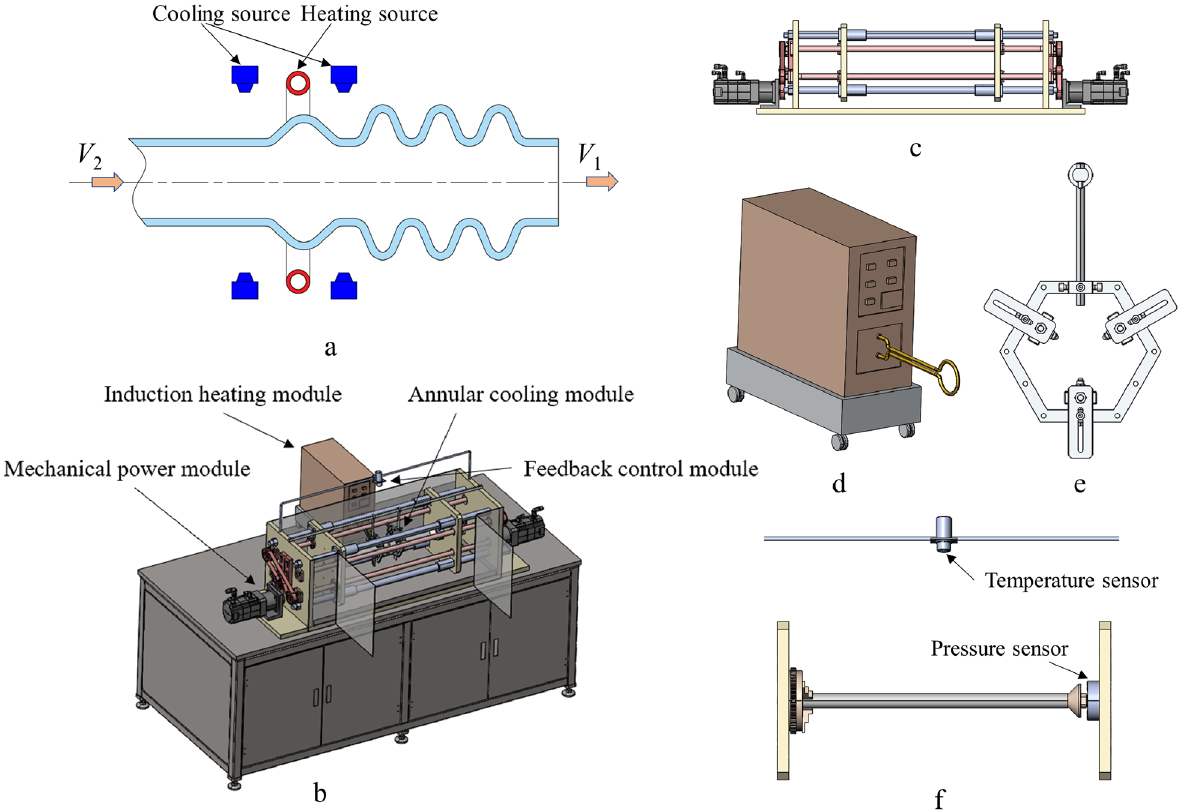
Figure 1 Schematic illustration of the forming apparatus: a Principle drawing, b Assembly drawing, c Mechanical module, d Induction heating module, e Annular cooling module, f Feedback control